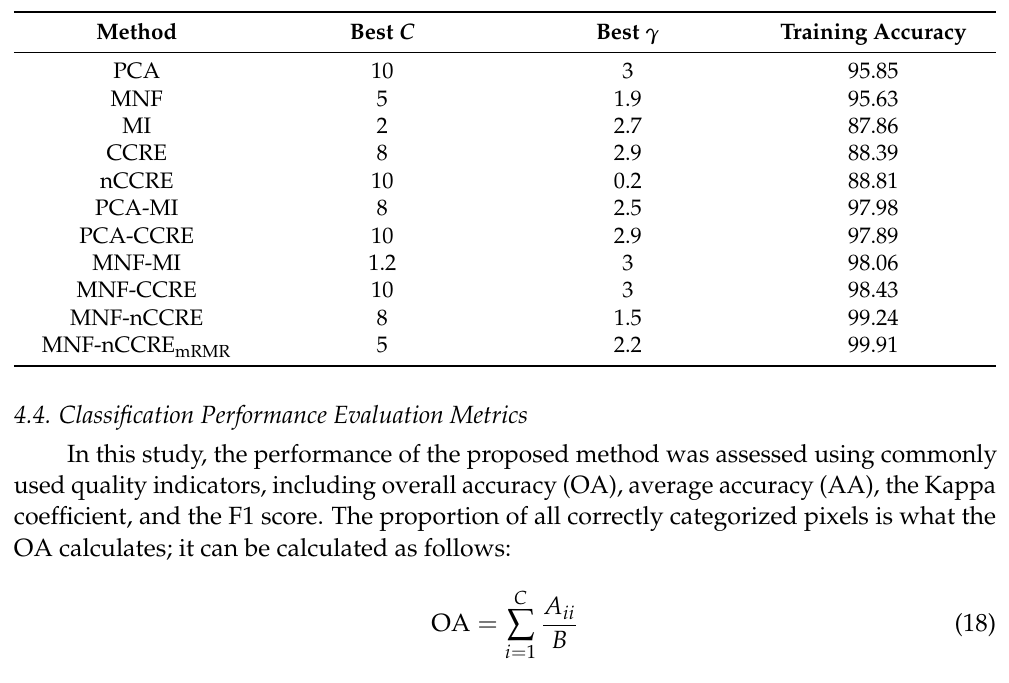
Table 8. Parameter tuning results using tenfold cross-validation for the ROSIS PU